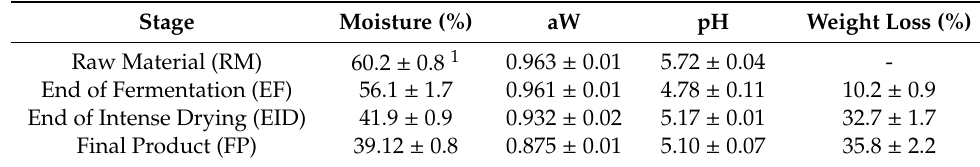
Table 1. Moisture, aW, pH, and weight loss results along the four stages of the process as mean values and standard deviation of batches 1 and